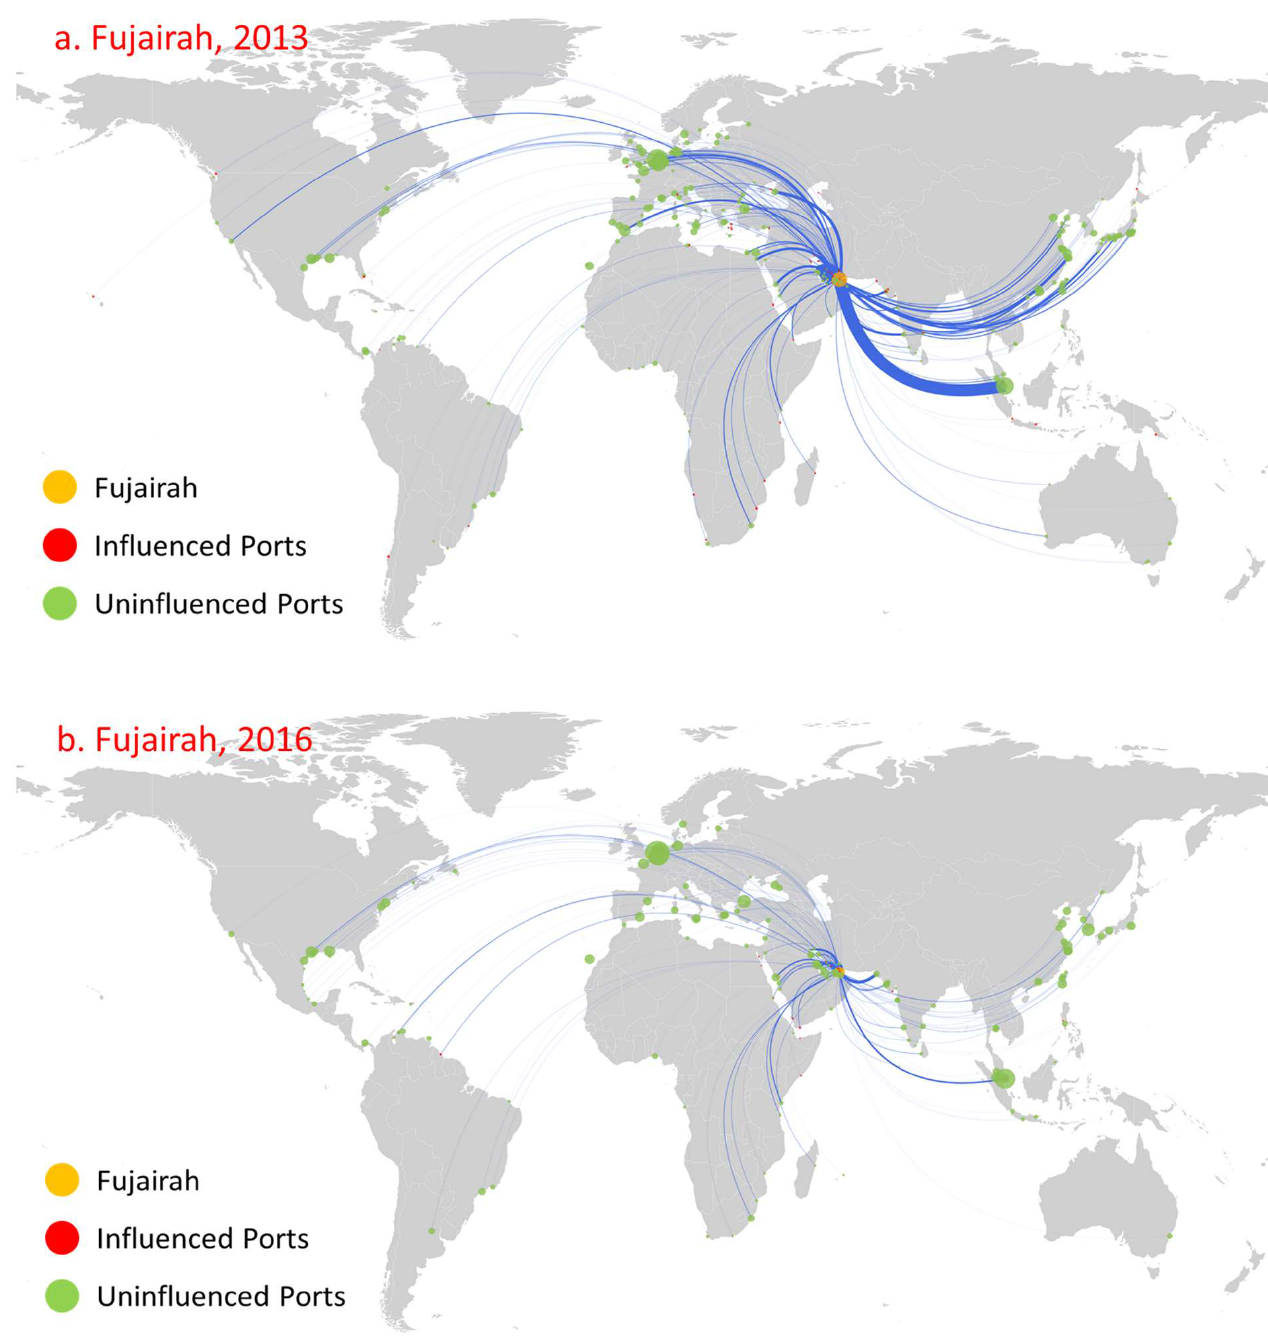
Figure 11. Influence diffusion at the first stage: Fujairah.